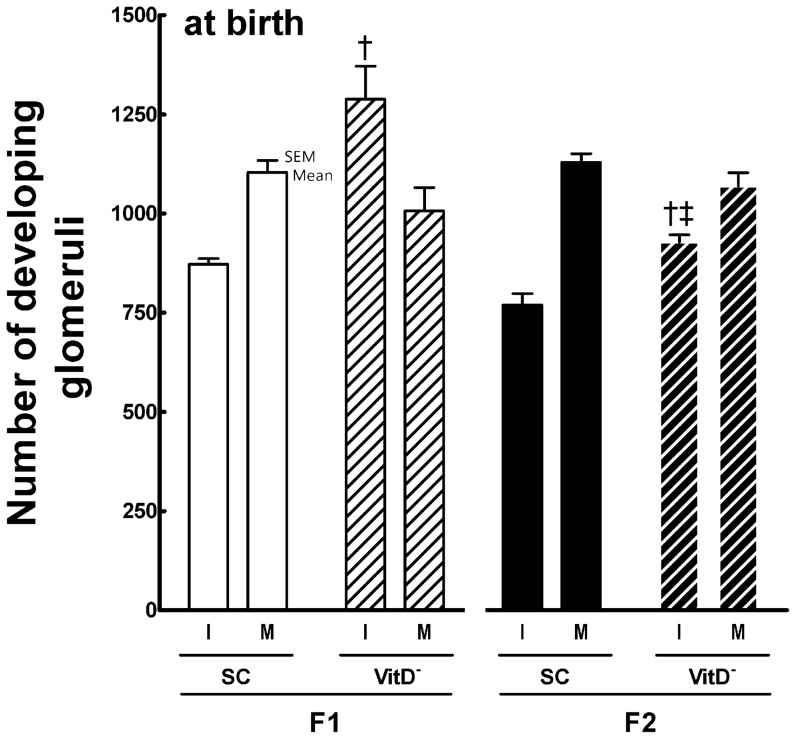
Number of developing immature and mature glomeruli at birth in both the F1 and F2 generations.Data are reported as means ± SEM; P<0.05, one-way ANOVA and post-hoc of Tukey's test: † compared to SC counterpart; ‡ compared to F1 generation.